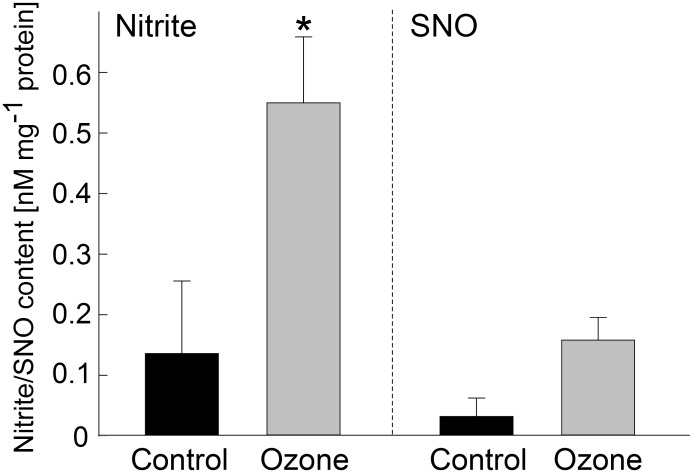
Nitrite and nitrosothiol (SNO) contents in grey poplar leaves upon acute ozone exposure (grey bars) compared to controls (black bars).Poplar plants were fumigated with ozone and harvested immediately after ozone treatment. 200 µg homogenized plant material was mixed with 600 µl PBS buffer containing NEM and EDTA. For nitrite and SNO determination, 100 µl and 200 µl of the plant extracts were, respectively, injected into the reaction vessel of Sievers NO analyzer containing the reducing agent tri-iodide. To measure SNO, the plant extracts were pre-treated with sulfanilamide to chemically remove nitrite. Values represent means ± SE of 3 biological replicates measured in three independent analyses. *P<0.05 (Student’s t-test).